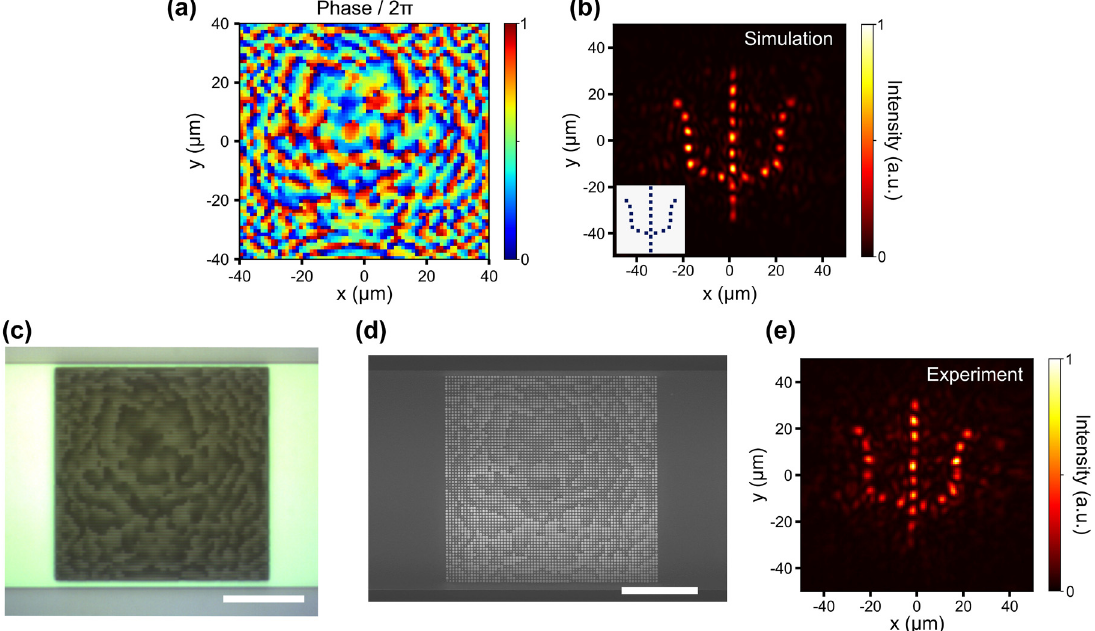
Figure 5: Simulation and experimental demonstration of an integrated meta-hologram. (a) Phase profile obtained by the Gerchberg–Saxton algorithm for projecting the letter ‘‘ ψ ’’ at 20 μ m above the metasurface. (b) Simulated intensity distribution at 20 μ m above the metasurface obtained by FDTD. Inset: target image. (c) OM image of the fabricated metasurface. (d) SEM image of the fabricated metasurface. Scale bar in panels c and d: 15 μ m. (e) Measured intensity distribution at 26 μ m above the